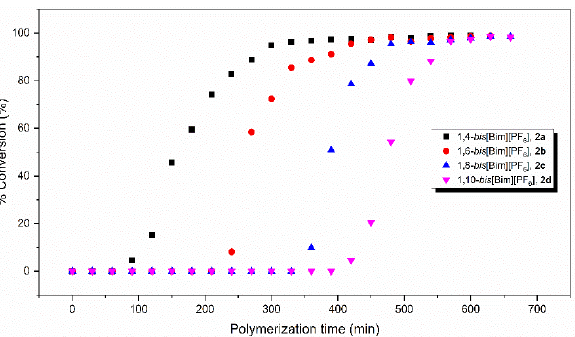
Figure 4. Plots of %polymer conversion against polymerization time for the ROP of CL catalyzed by 0.50 mol% of DILs ( 2a – 2d ) with 1.0 mol% of n C 12 H 25 OH at 150 °C.